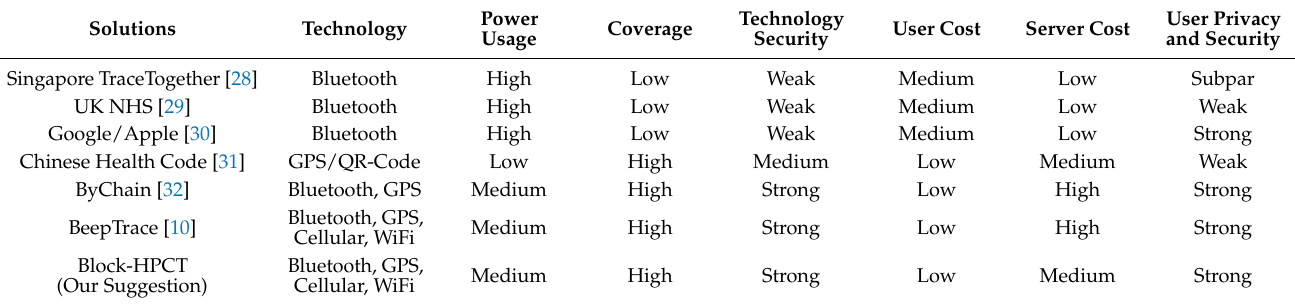
Table 2. Comparison among different contract tracing